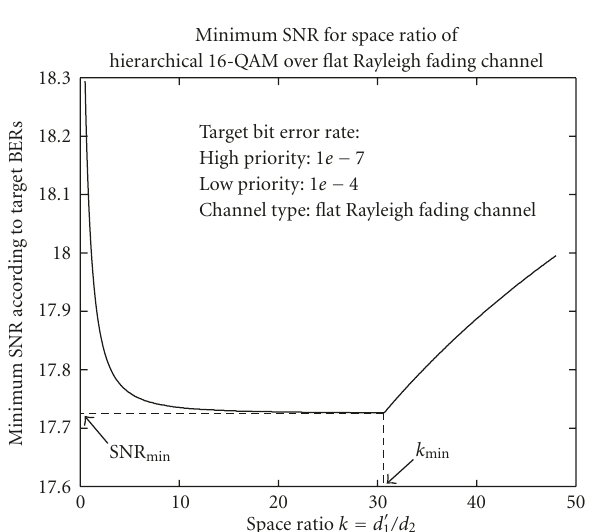
Figure 9: SNR versus k curve over flat Rayleigh fading channel. The overall SNR gets minimum value of 17 . 72 dB when the space ratio k = 37 .